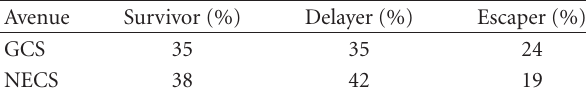
∗ The row categories are not mutually exclusive, but dementia tends to be positively associated with psychiatric disorders (Figure 1(b)). The associa- tion of Dementia with age (Control versus Centenarian) is significant with P < . 00001 by Fisher’s Exact test [14] for a 2 × 2 table, but the associations of Depression, Anxiety, and Psychosis individually with age (Control versus Centenarian) are not significant with P > . 05. If we combine mental health across Depression, Anxiety, and Psychosis and test for association with age (Control versus Centenarian) by Fisher’s Exact test [14] for a 2 × 2 table, the association of the aggregate variable indicating Depression, Anxiety, or Psychosis with age is not significant. The percents reported in this table are among 80 octogenarians or 244 centenarians.